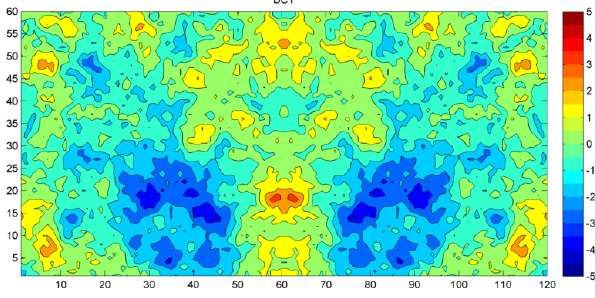
Figure 5. Same as in Fig. 4, but for DCT. The periodization is shown only for x